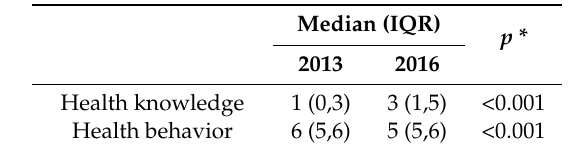
Table 3. Overall score of hypertension related knowledge and behavior.